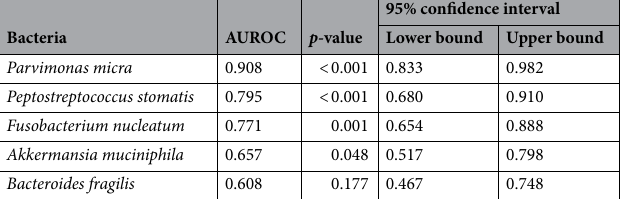
Table 5. Enriched abundance of Pm, Ps, Fn and Am in CRC patients (validation cohort).